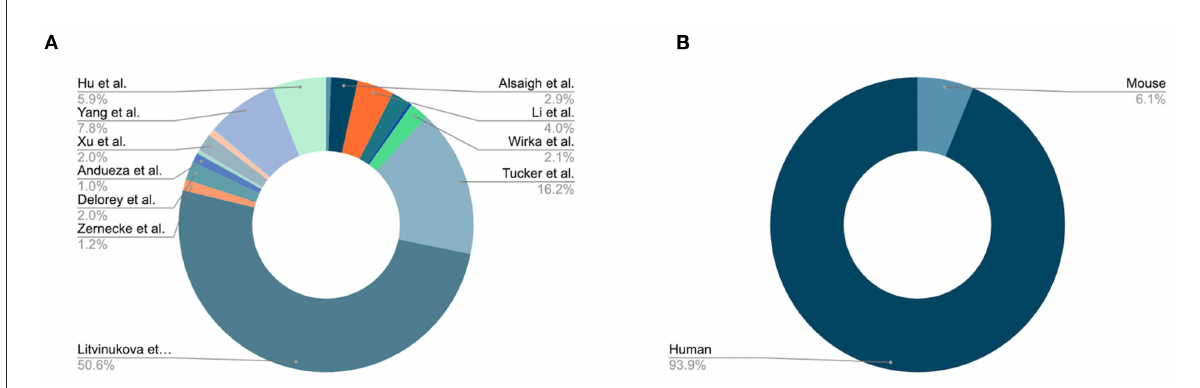
FIGURE1 PlaqView 2.0 incorporates 32 cardiovascular-related datasets. (A) Major datasets available on PlaqView. PlaqView brings high-performance computing directly to the browser in order to handle large datasets such as ones from Litvinukova et al., which are atlas-type survey data that contain tissues from the entire human heart. (B) Species composition of PlaqView’s